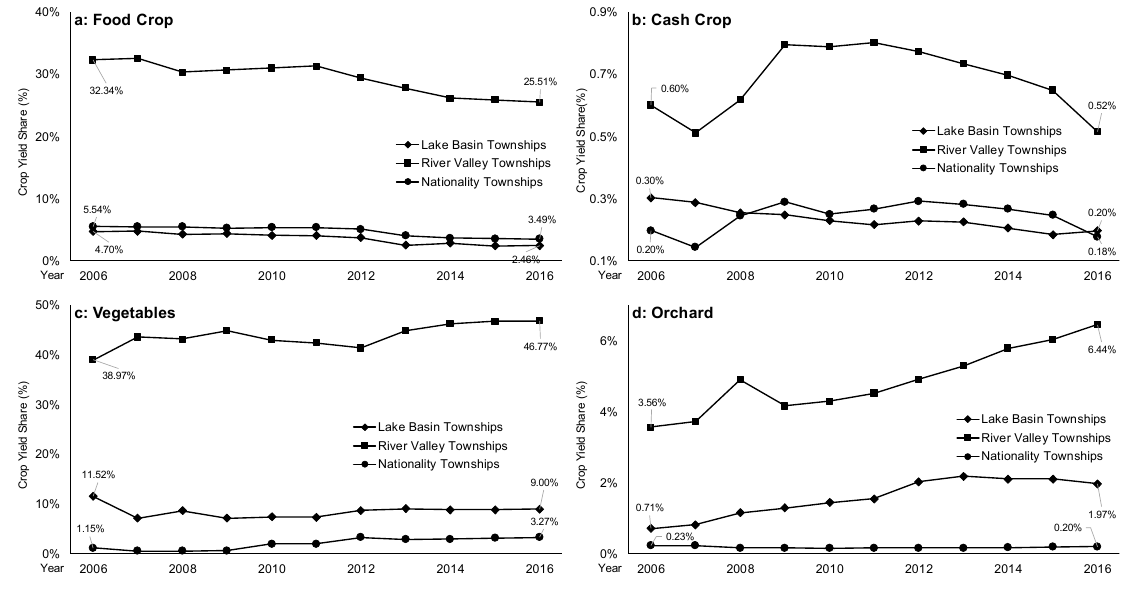
Figure 8. Agricultural yield structure in the various township zones.